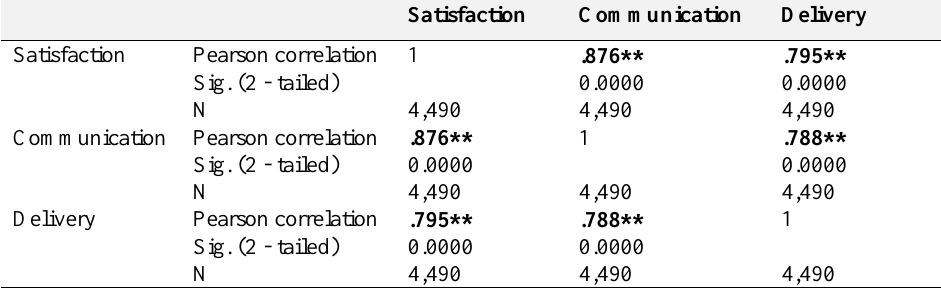
Table 9 – Pearson’s correlation E-shops in